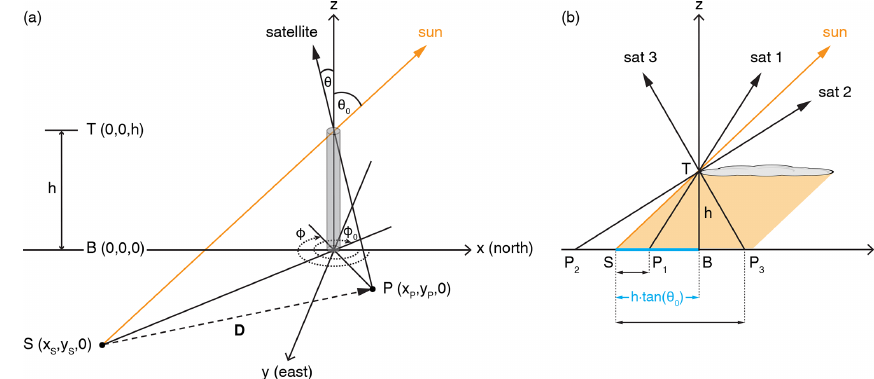
Figure 3. Sun-satellite-shadow geometry for (a) a narrow vertical eruption column under arbitrary viewing and illumination conditions and (b) a horizontally expanded suspended ash layer in the solar principal plane of panel (a) . In panel (b) , the cyan line segment represents the true (stick) shadow length, and the orange coloring indicates the area in the shadow of the ash